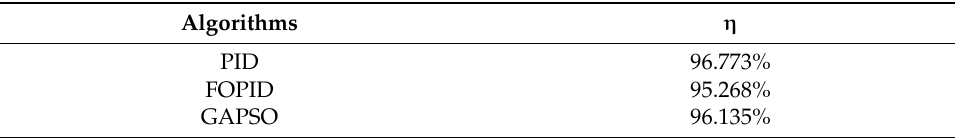
Figure 19. L = 5 m, V = 0.2 m/s, Heave errors with and without compensation.